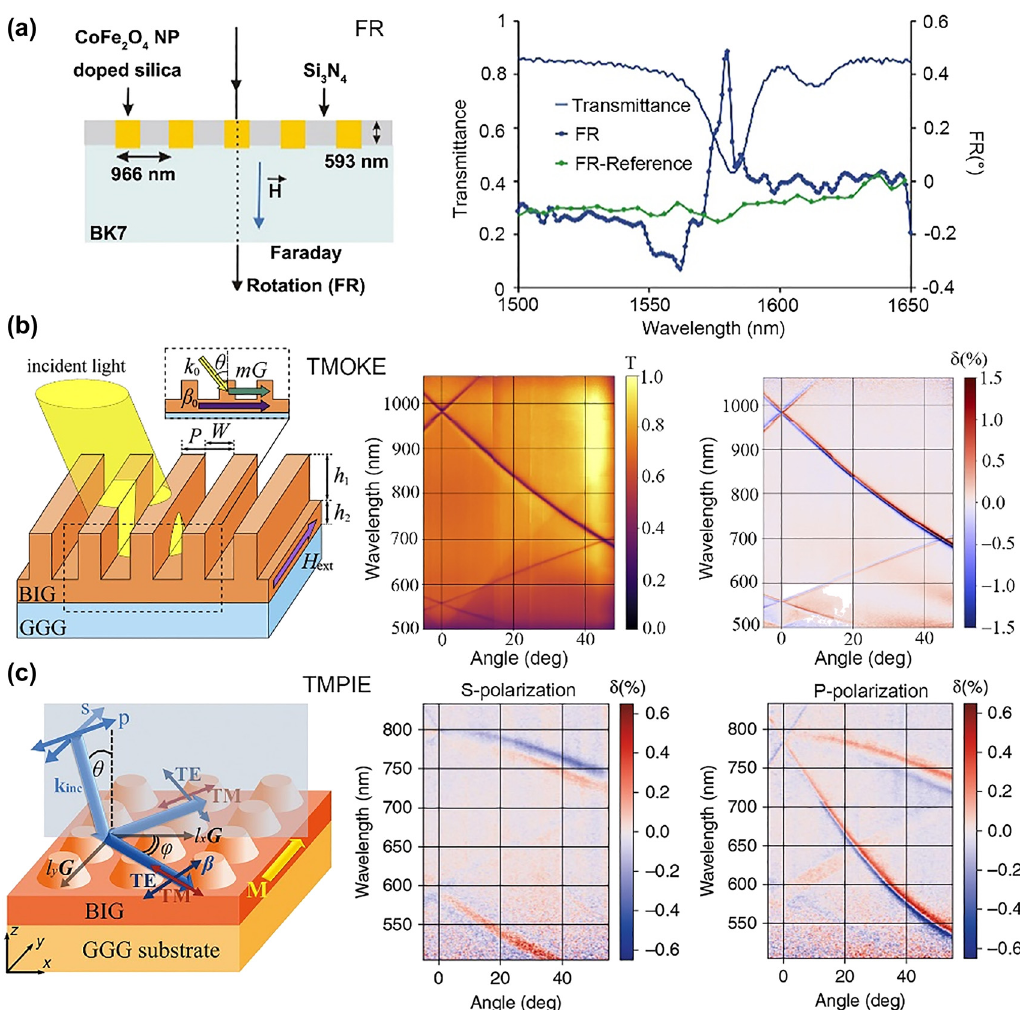
Figure 5: Waveguide modes in all-dielectric MO subwavelength gratings. (a) SiN/CoFe 2 O 4 nanoparticle doped SiO 2 grating and the enhanced Faraday effect. The right fi gure presents the transmission and FR spectra, showing large FR enhancement at the Mie resonance wavelength. (b) Structure, transmittance, and TMOKE in BIG 1D subwavelength grating structures on gadolinium gallium garnet (GGG) substrates. (c) Structure and TMPIE for both s and p polarized incidences of 2D BIG subwavelength gratings on GGG substrates. The panels of this fi gure contain pictures adapted from References [62, 105,